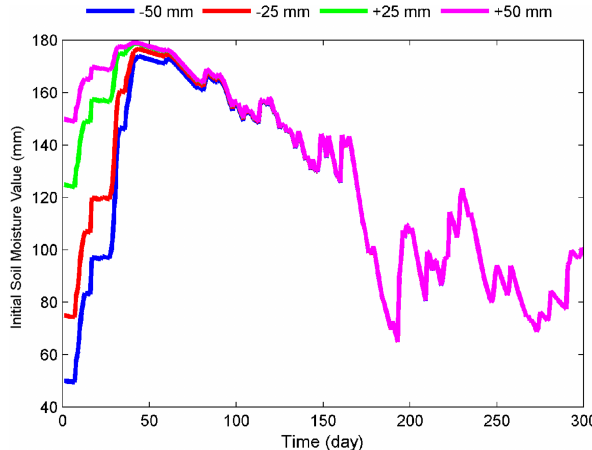
Fig. 4. Investigating the effect of initial value of soil moisture in streamflow